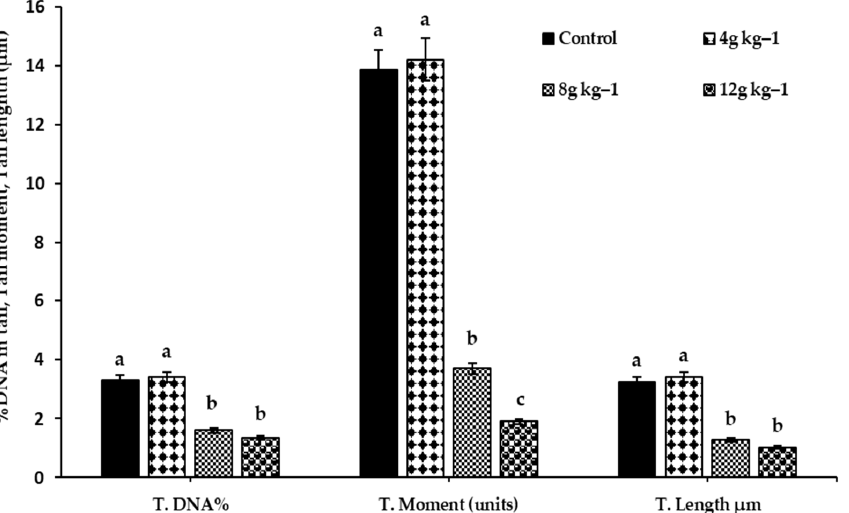
Figure 4. Effect of feeding on diets supplemented with SMS at different levels (4, 8, 12 g kg − 1 diet) during duck brooding period on the liver’s DNA comet assay at the end of the experiment. a,b,c : Bars within the same attribute not sharing a common letter are significantly different ( p < 0.05).